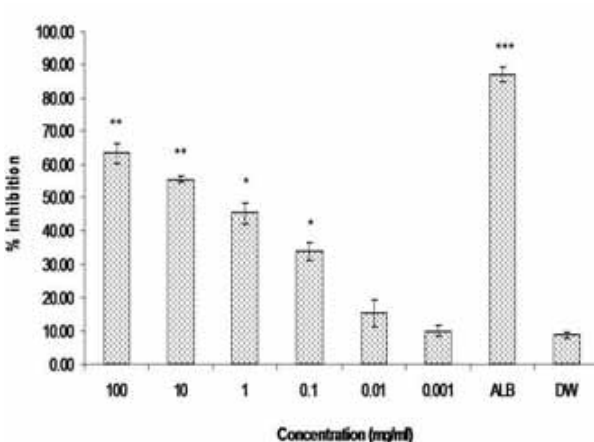
Figure-1: The effect of crude methanol Figure-2: The effect of crude methanol extract (0.001-100 mg/ml) and albendazole (ALB) (0.25 extract (0.001-100 mg/ml) and albendazole (ALB) (0.25 mg/ml) on hatching of eggs. Control mg/ml) on hatching of eggs. Control group was dosed with distilled water (DW) at 5 mL/kg. group was dosed with distilled water (DW) at 5 ml/kg. Values Values are mean ± S.E.M. ***p 0.001, **p 0.01 and are mean ± S.E.M. ***p 0.001, **p 0.01 and *p 0.05 ***p 0.05 showed significant difference when compared showed significant difference when compared with distilled with distilled water-treated control group. water-treated control done in three replicates.At the end of the sixth day after incubation, the different larval stages of the parasites (L ,L andL )fromeachwellwererecovered and counted eggs when under a light microscope at × 40 magnifi-cation. The percent (%) inhibition of egg hatching and larval development was calculated by using the formula described by Coles [16]. Percent inhibition = 100 (1-P /P )